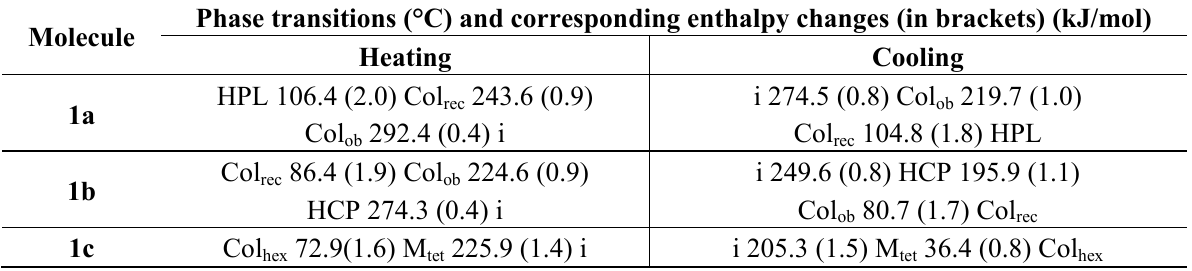
Table 1. Thermal transitions and corresponding enthalpy changes of molecules 1a – 1c